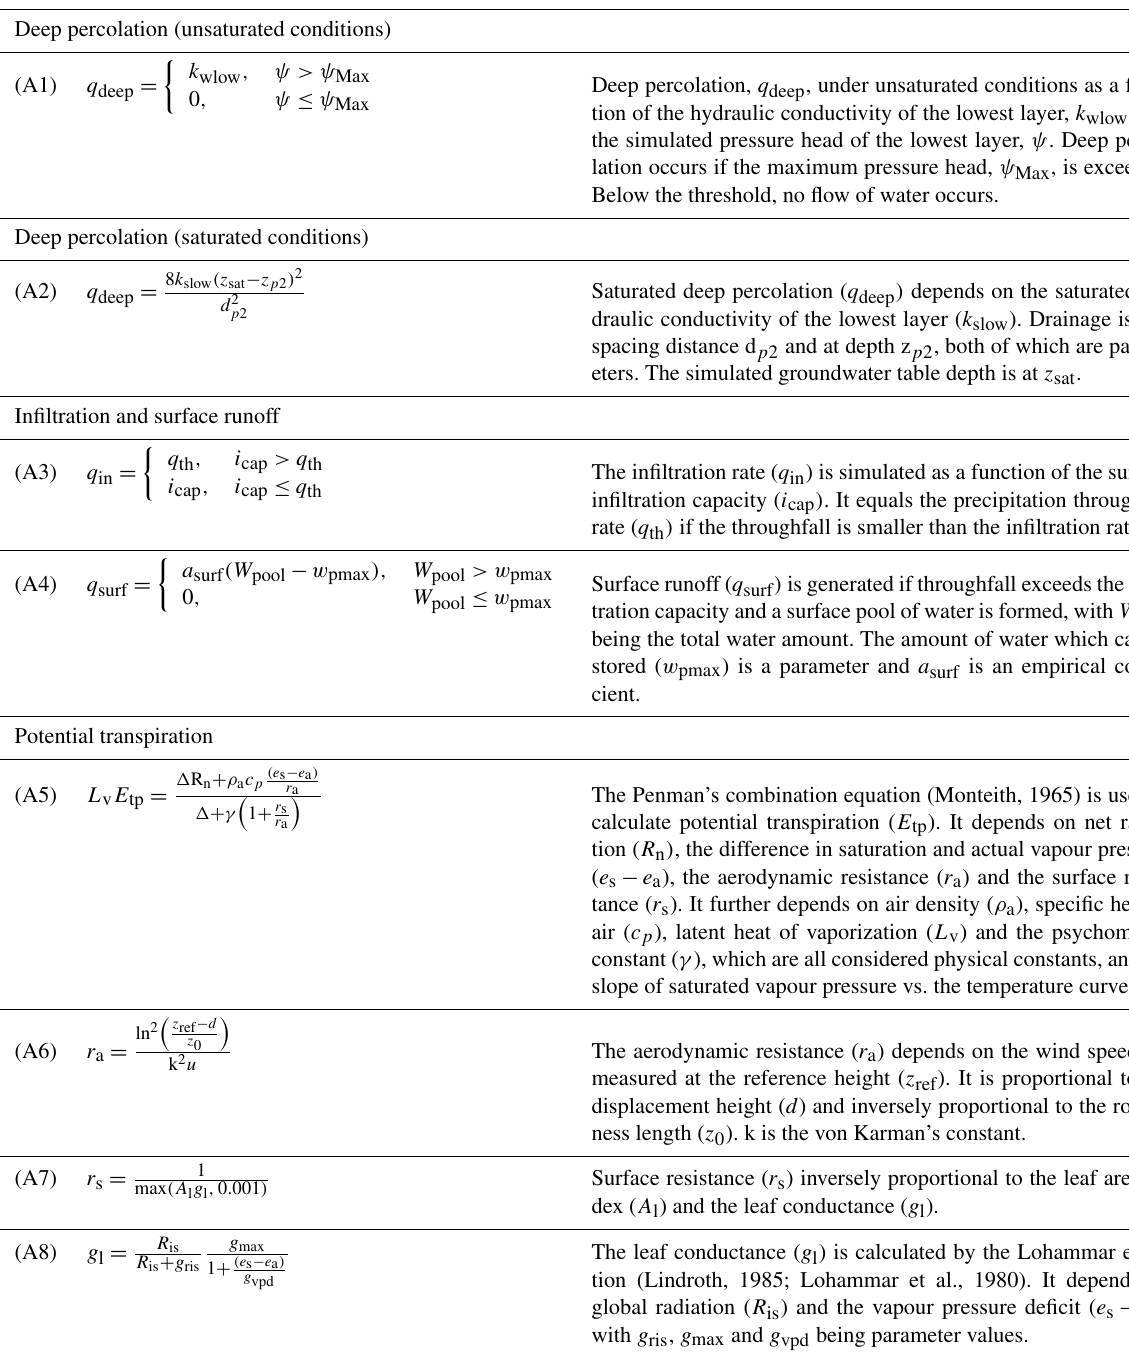
Table A1. Key equations of the CoupModel used for this study (see Jansson and Karlberg, 2011, for more details). No. Equation Description Deep percolation (unsaturated